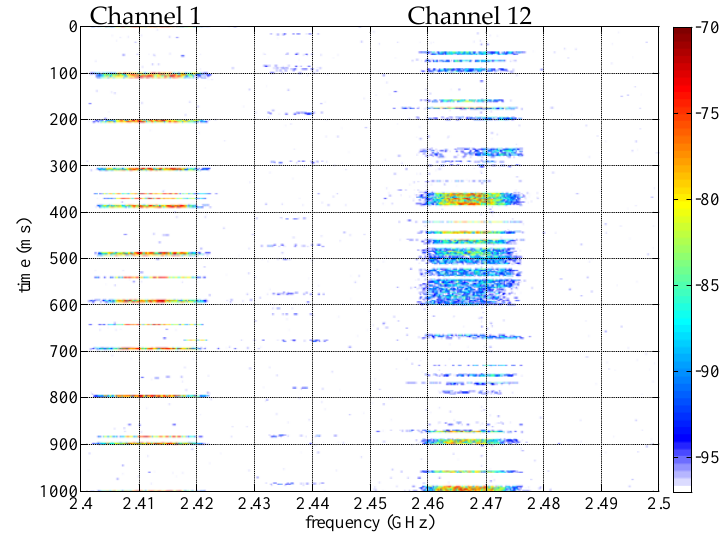
Figure 3. Time-frequency map from 2.4 GHz to 2.5 GHz.